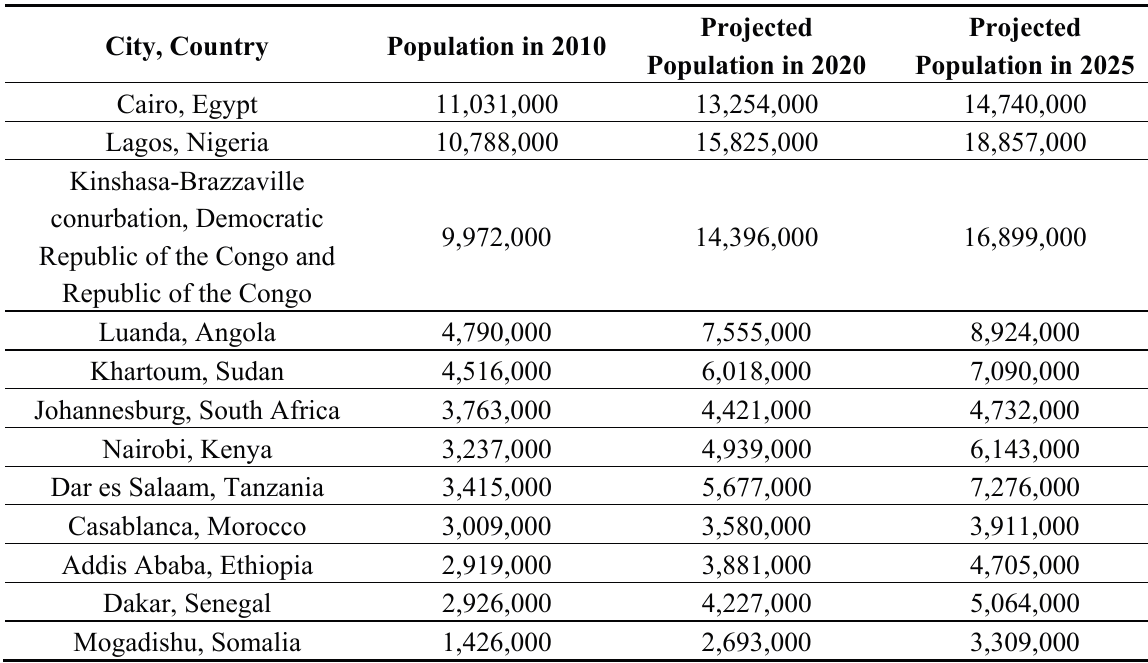
Table 2. Population per city as reported by the United Nations Human Settlements Programme